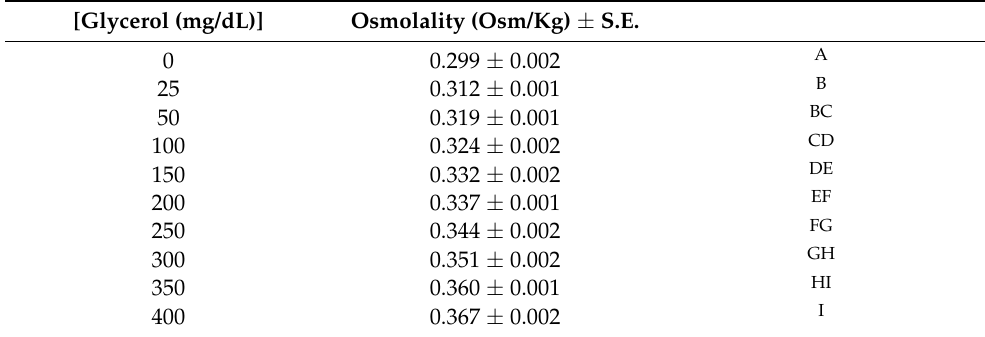
Table 2. Osmolality values of media supplemented with increasing glycerol concentrations. Upper- case letters indicate differences between groups ( p < 0.01—one-way ANOVA-Tukey post hoc test).